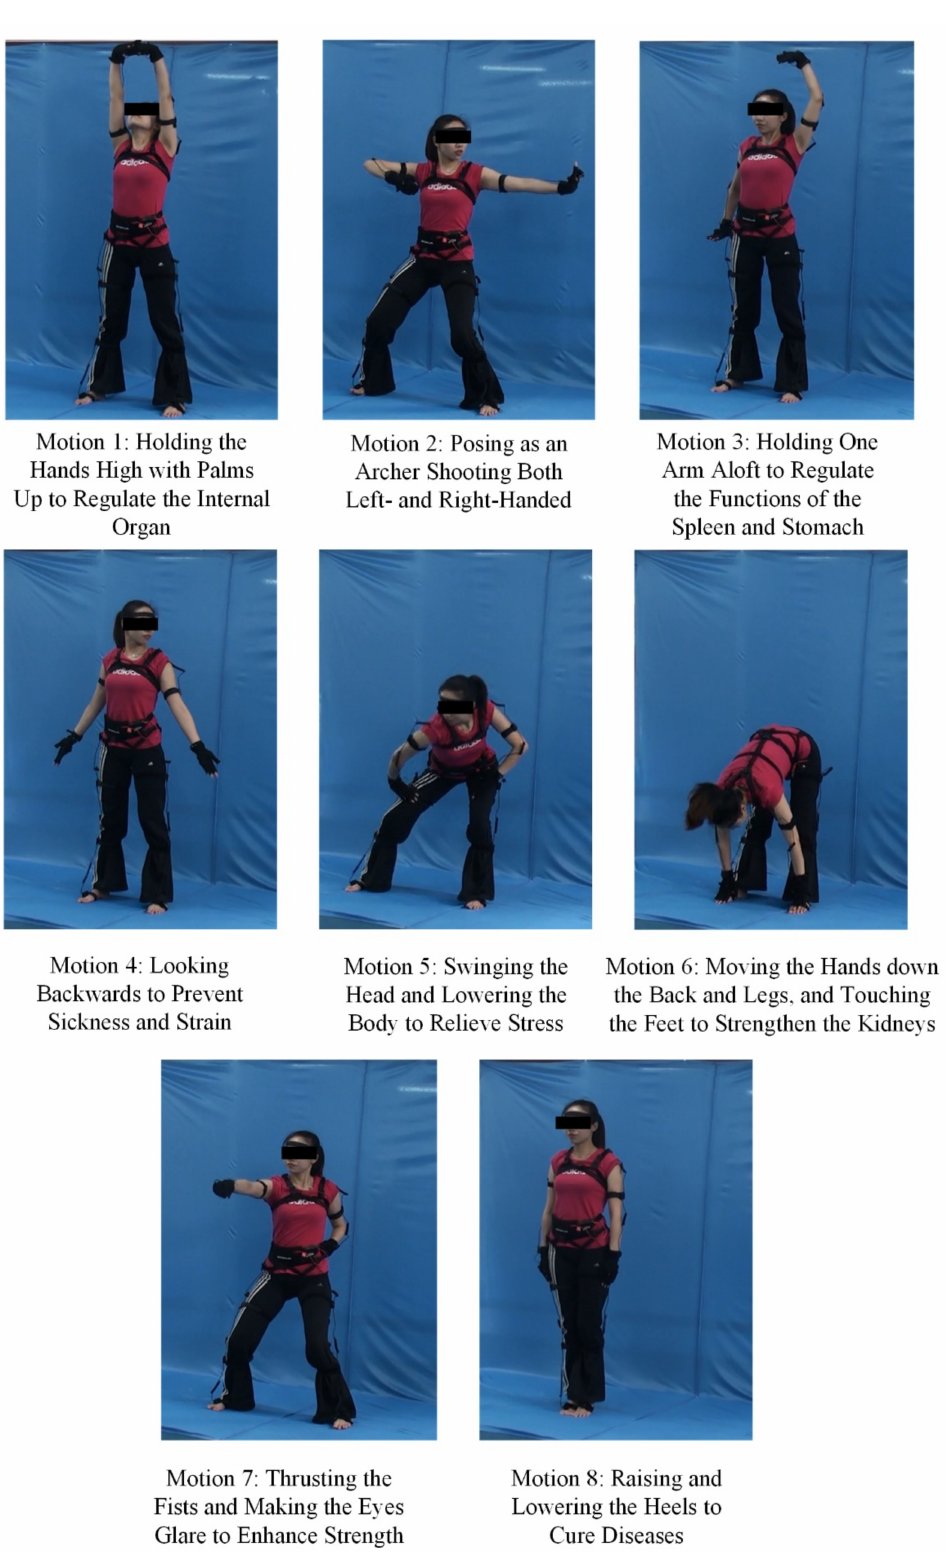
Figure 2. Eight standard motions of